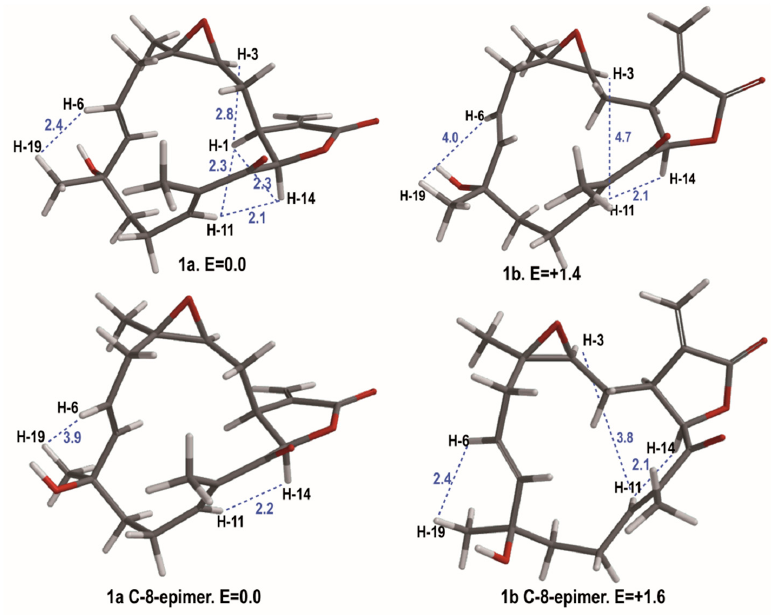
Figure 3. The two lower energy conformers for each C-8 epimer of uprolide N ( 1 ). Relative energies are expressed in Kcal ∙ mol − 1 . Selected distances (in blue) are given in Å.